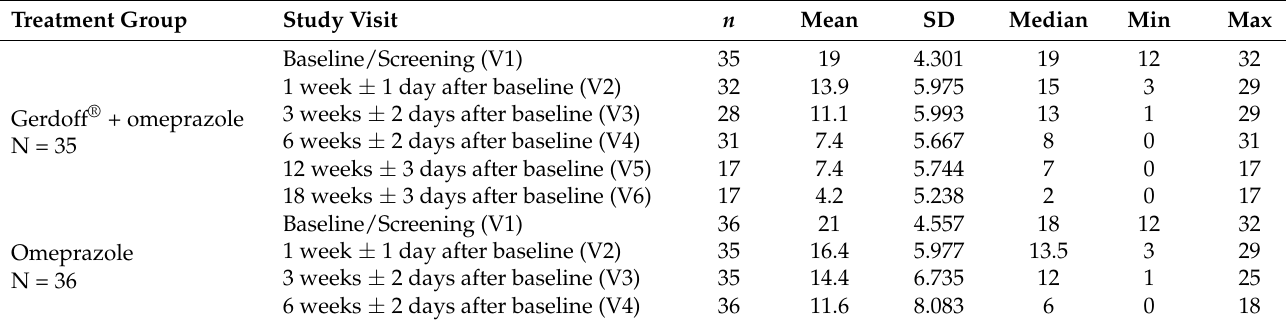
Table 7. Summary of total Likert scale scores at any time point. Treatment Group Study